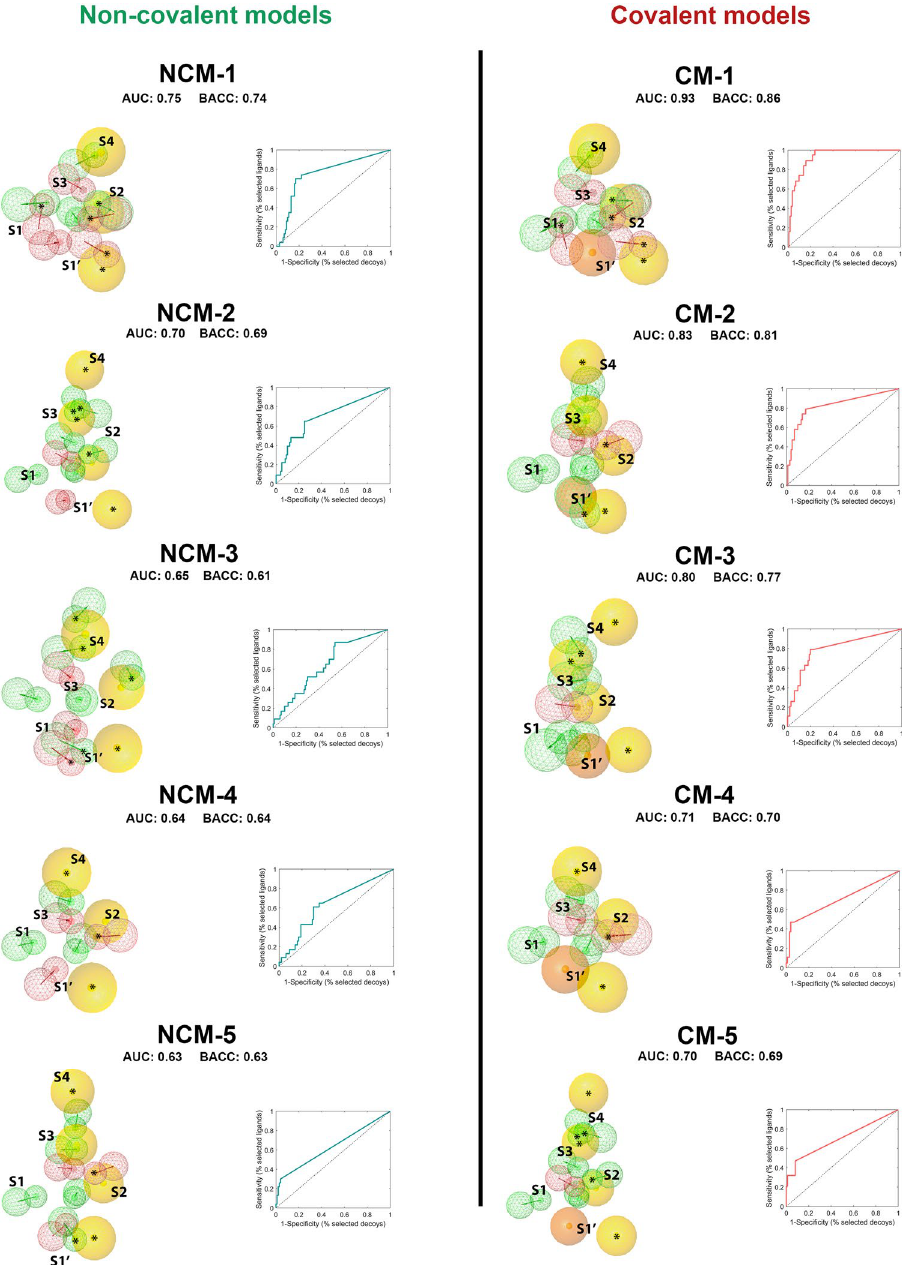
Figure 5. Protein–ligand-based pharmacophore models and ROC curves. The models are ordered from best to worst according to ROC-AUC and BACC values. Non-covalent models (NCM) on the left and covalent models (CM) on the right. HBD (green), HBA (red), hydrophobic (yellow), residue bonding point (orange), and optional feature (*). Each pharmacophore model corresponds to an active-site-conformation cluster, conventions can be found in Figure S49 and Figure